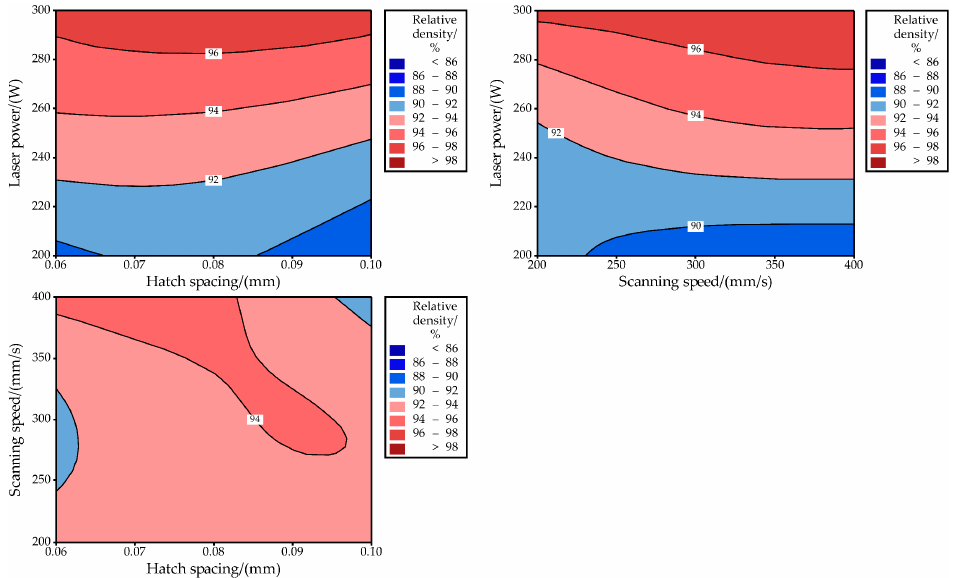
Figure 7. Contour plot showing the influence of process parameters on the RD of as-built W.